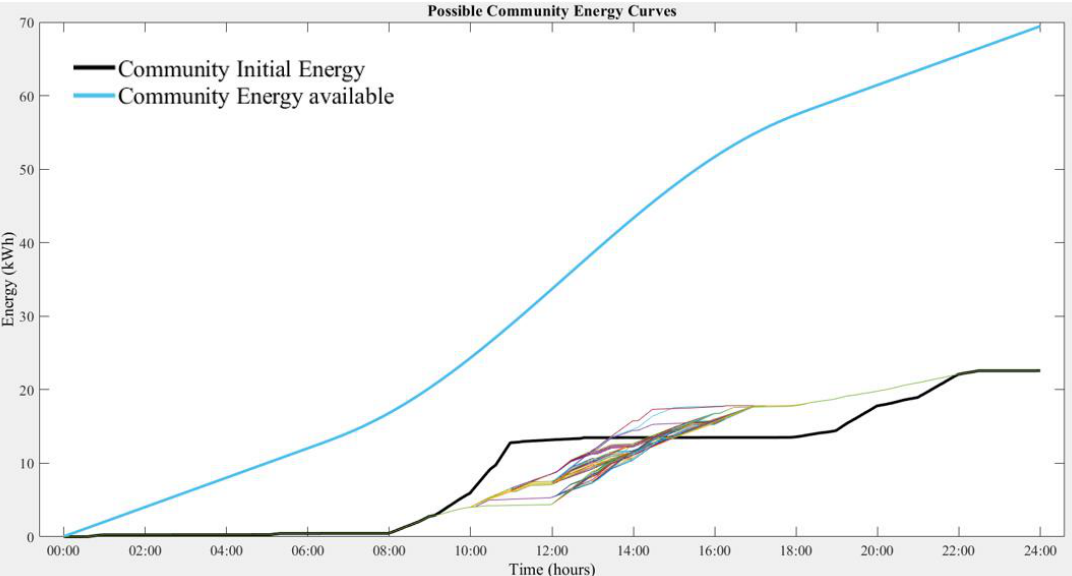
Figure 17. The community ’ s energy profile in Scenario 2.